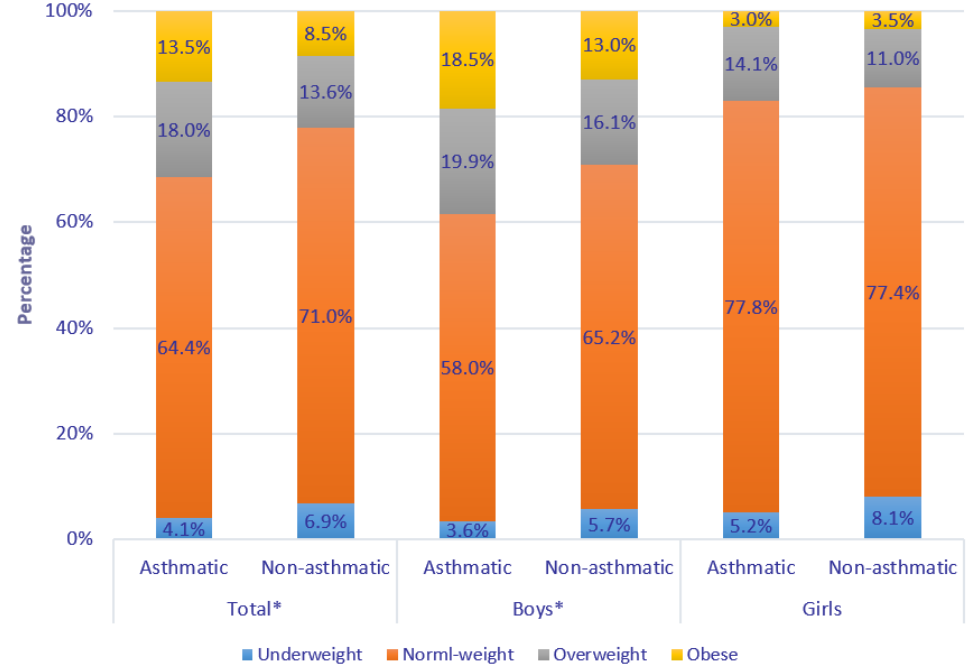
Figure 1. Distribution of weight status in children with or without physician-diagnosed asthma. Note: Difference of weight status between children with and without physician-diagnosed asthma was evaluated using Chi-square tests; * p < 0.05.